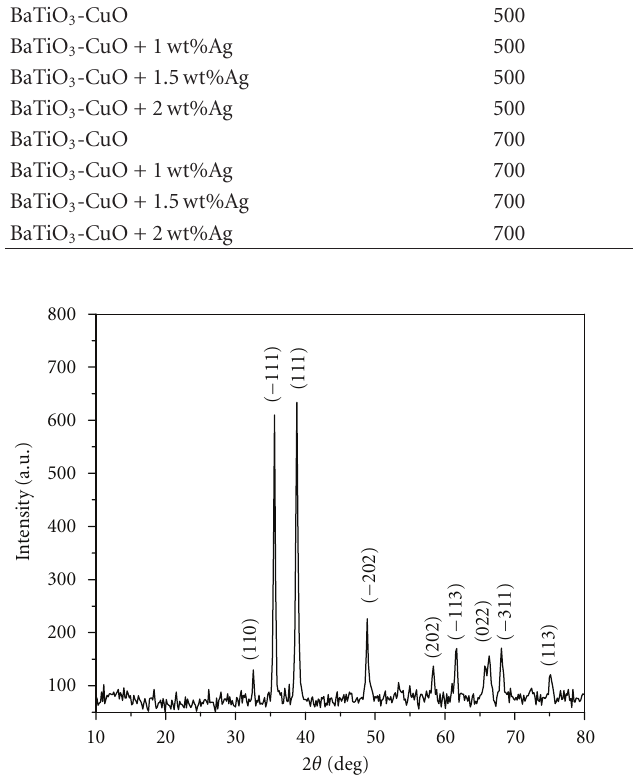
Table 1: Average crystallite sizes of the sensor samples components sintered at di ff erent temperatures. Samples